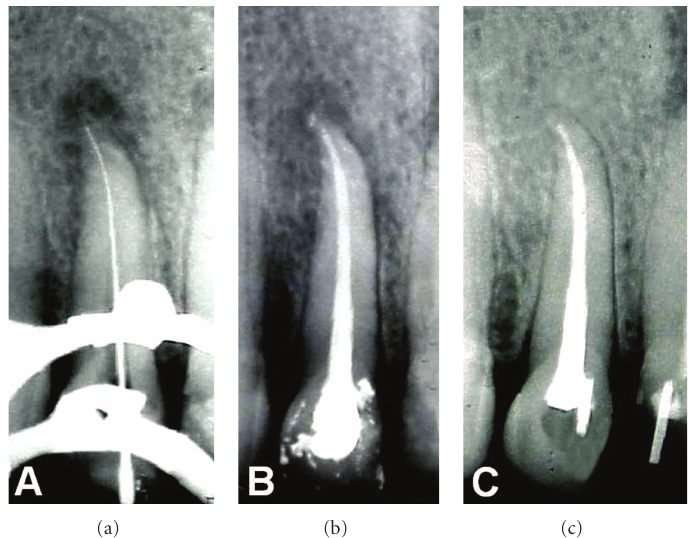
Figure 3: (a) Preoperative radiograph of a maxillary left lateral incisor presenting with a periapical radiolucency. (b) Immediate postoperative radiograph. (c) After 10 years, the recall radiograph revealed that the periapical structures had returned to